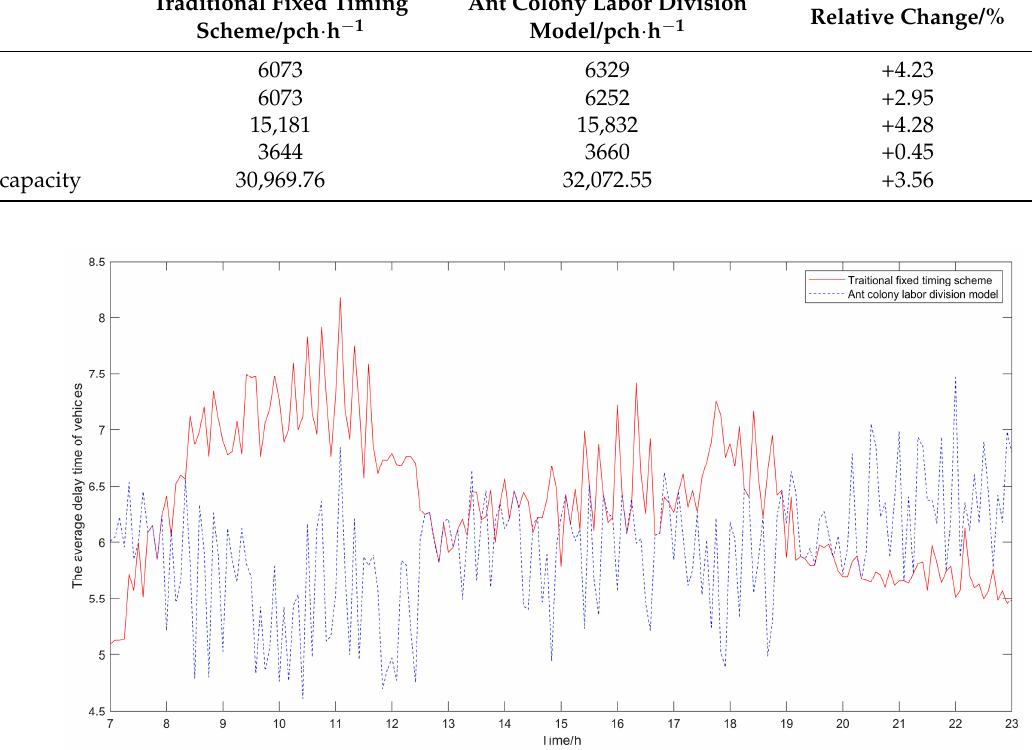
Figure 5. Comparison diagram of average vehicle delay time.